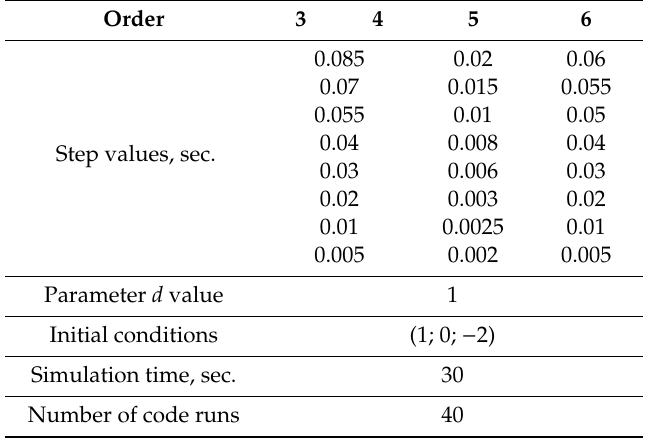
Table 5. Parameters used in experiments with the Sprott Case E